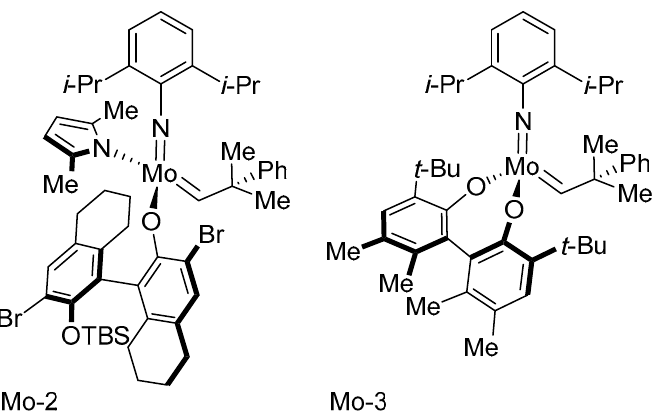
Figure 6. Commercially available chiral molybdenum alkylidene complexes tested in atroposelective synthesis of binaphthalenes.